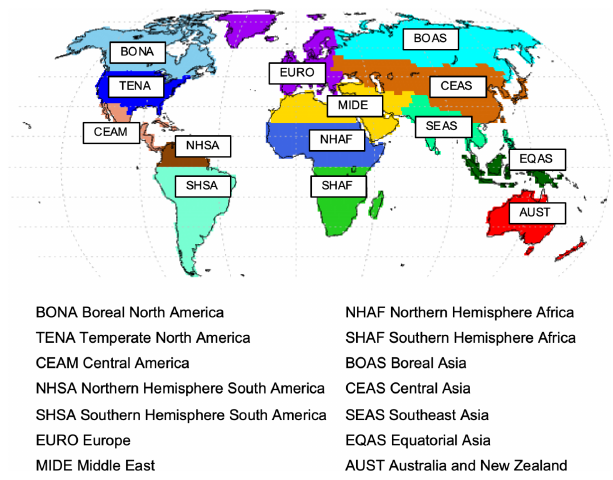
Figure 1. GFED (Global Fire Emissions Database) basis regions regridded to the resolution of ModelE2.1 of 2 ◦ in latitude by 2.5 ◦ in